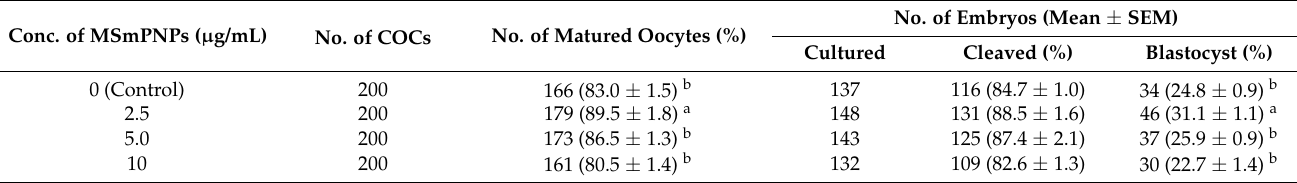
Table 4. Effect of in vitro maturation of porcine oocytes with different concentrations of MSmPNPs on in vitro development rate of SCNT embryos.